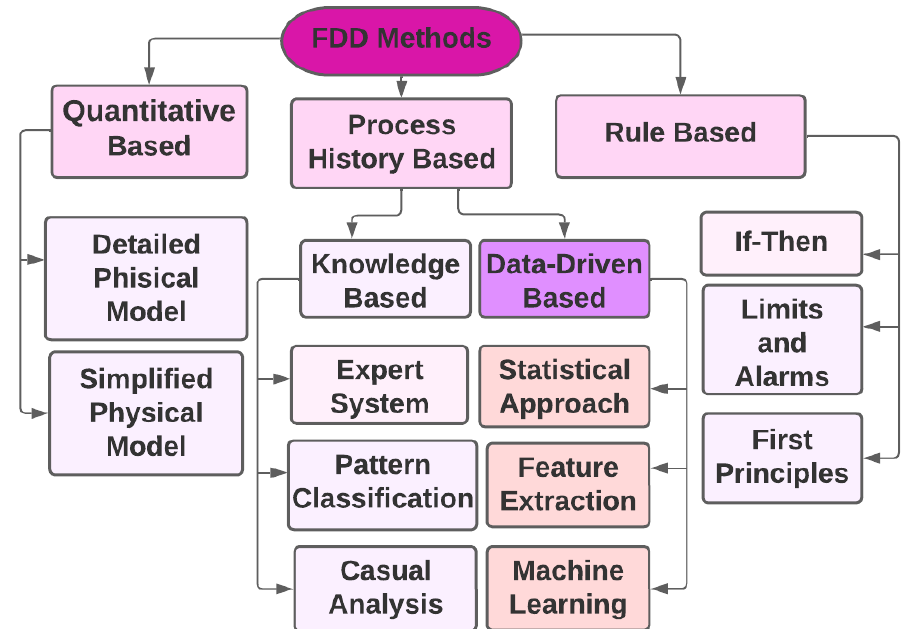
Figure 3. Fault detection and diagnosis methods. Based on